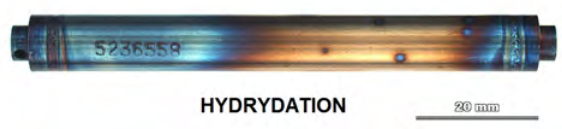
Figure 4. The typical outlook of specimen after hydrogen charging